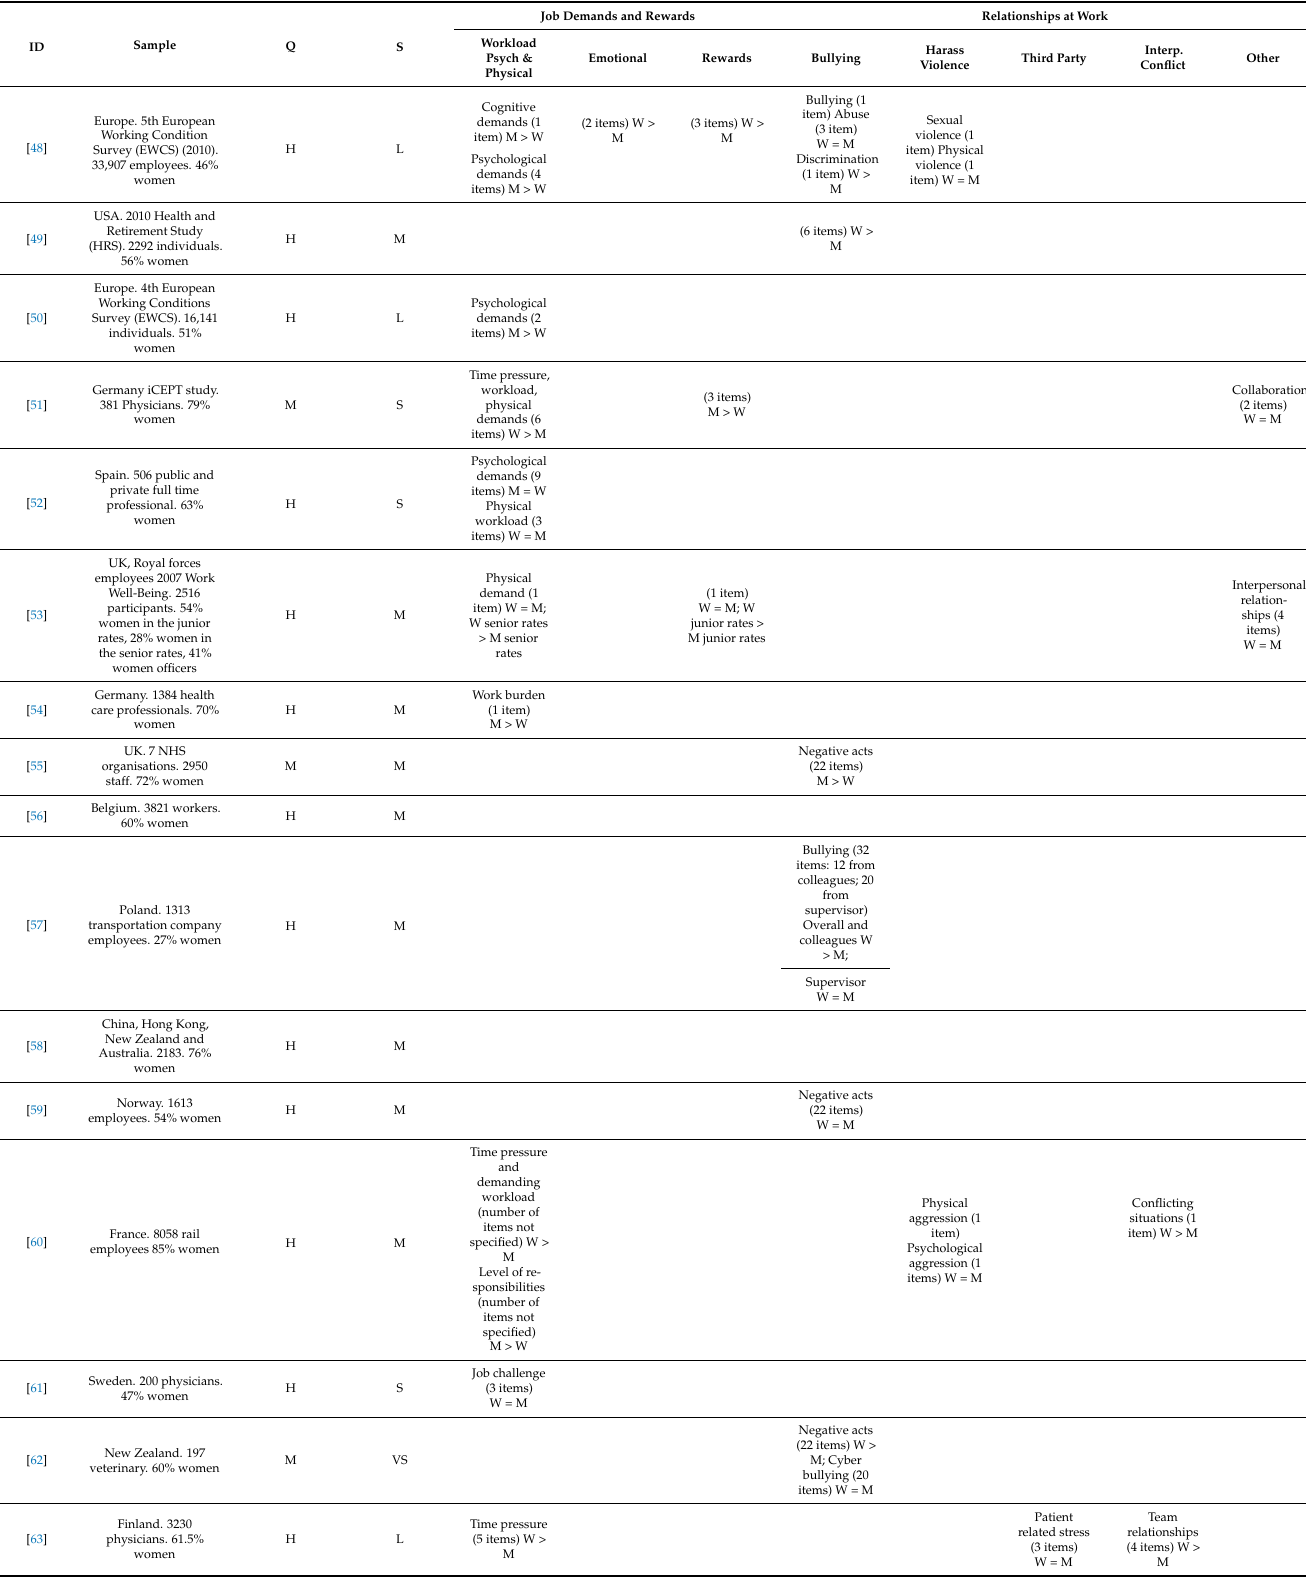
Table A1. Overview of the papers included in the literature review. Panel